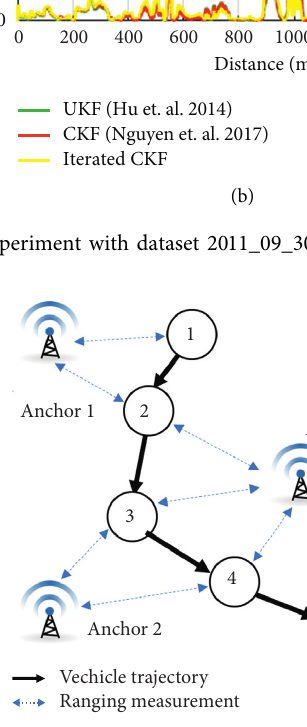
Figure 13: Illustration of wireless communication process with minimum pseudorange measurements.